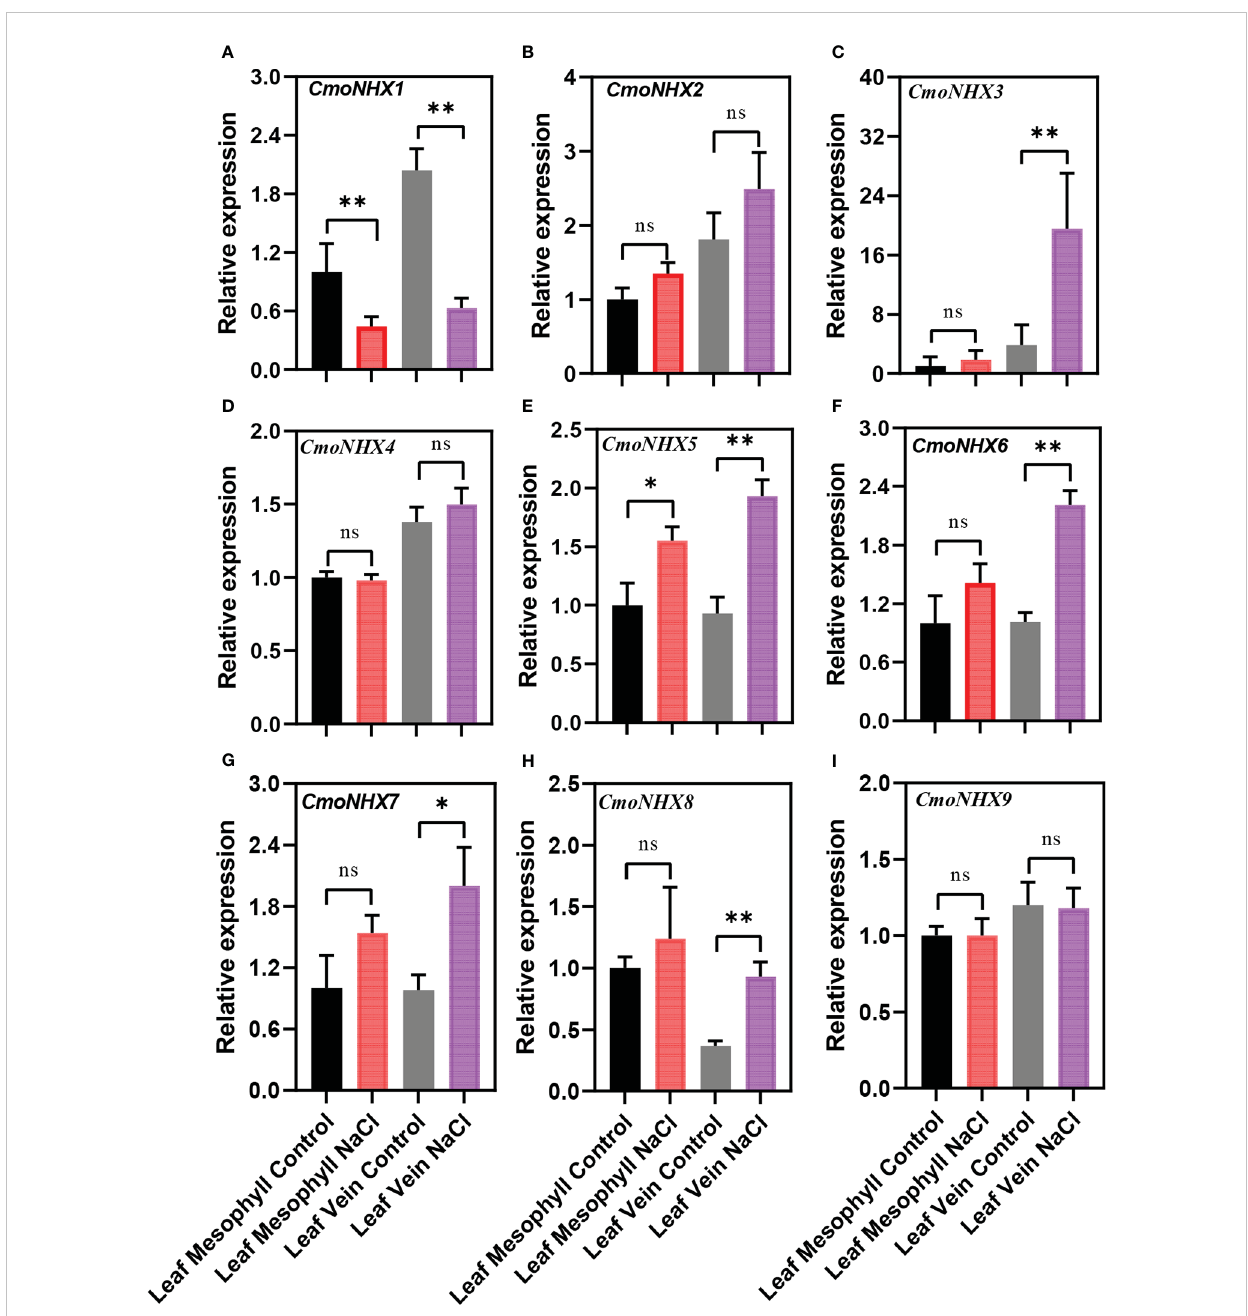
FIGURE 6 Relative expression of NHX genes from the leaf mesophyll and leaf veins of C. moschata ( “ Rifu ” ) in response to treatment with 100 mM NaCl for 24 h. Each data represents the average from three samples. The error bars represent the SDs. * indicates signi fi cance at p < 0.05, ∗∗ indicates signi fi cance at p < 0.01, NS indicates no signi fi